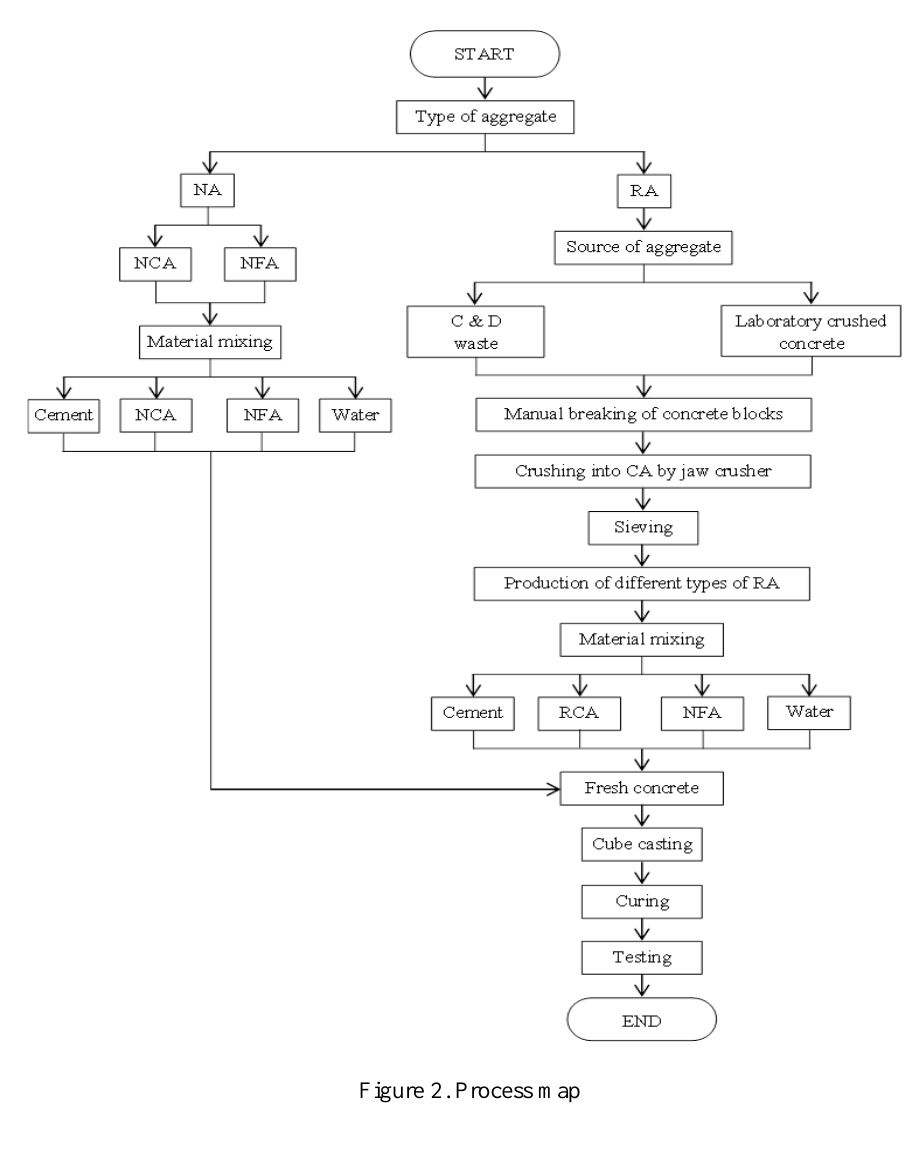
Figure 2. Process